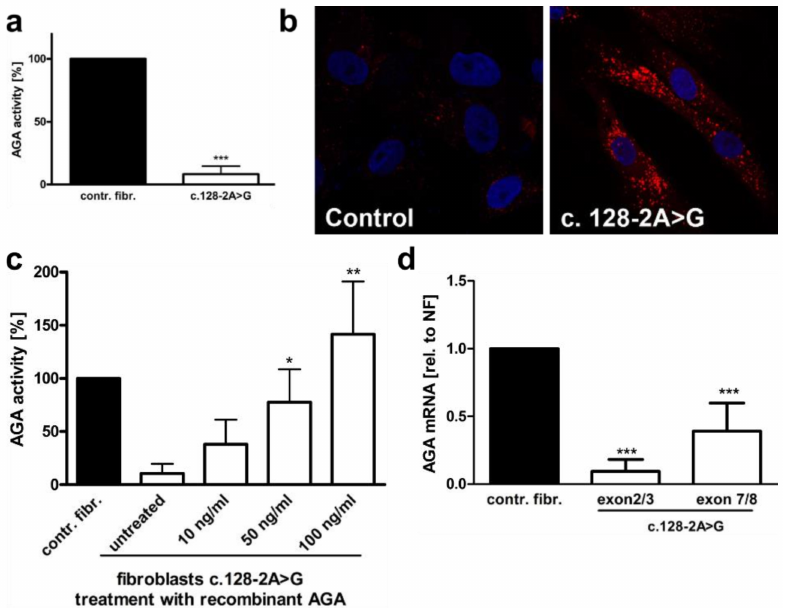
Figure 2. Characterization of the c.128-2A>G AGU variant. ( a ) Control and c.128-2>G AGU fibroblasts were lysed, and the AGA activity was measured fluorometrically. Eleven independent experiments were performed. The graph shows the mean of the data ± SD. Statistical analysis was performed with unpaired t test. ( b ) Control fibroblast and the fibroblasts of the patient were stained with Lysotracker-red to visualize lysosomal abnormalities. ( c ) The patient fibroblasts were treated with the indicated amounts of recombinantly expressed, Strep-tagged AGA fusion protein for 48 h, and the AGA enzyme activity was measured and compared with the control fibroblasts whose activity was set to 100%. ( d ) Quantitative real-time PCR of AGA mRNA in patient fibroblasts with the c.128-2A>G variant. AGA transcript was detected with two different primer pairs, one for exons 2 and 3 and the other one for exons 7 and 8. The c.128-2A>G variant leads to skipping of exon 2, as indicated by the lower transcript amount with the exons 2+3 primers as compared to the primer pair for exons 7+8. Bars represent the mean ± SD of 10 independent experiments. Statistical analysis was done by one-way ANOVA against the control fibroblasts. Values of p < 0.05 were considered significant (*) while values of p < 0.01 were considered very significant (**) and p < 0.001 extremely significant